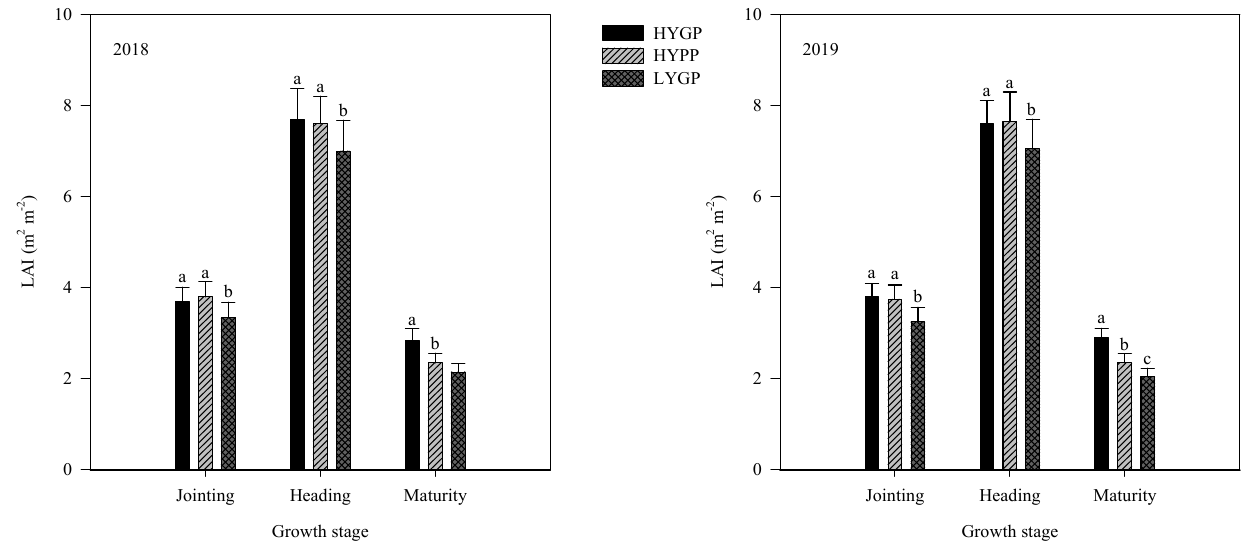
Figure 2. LAI at the jointing, heading, and maturity of rice cultivar types. LAI, leaf area index; HYGP, high-yielding rice with good palatability; HYPP, high-yielding rice with poor palatability; LYGP, low-yielding rice with good palatability. Different lowercase letters in the same growth stage above the histogram indicate statistical significance at the p < 0.05 level.